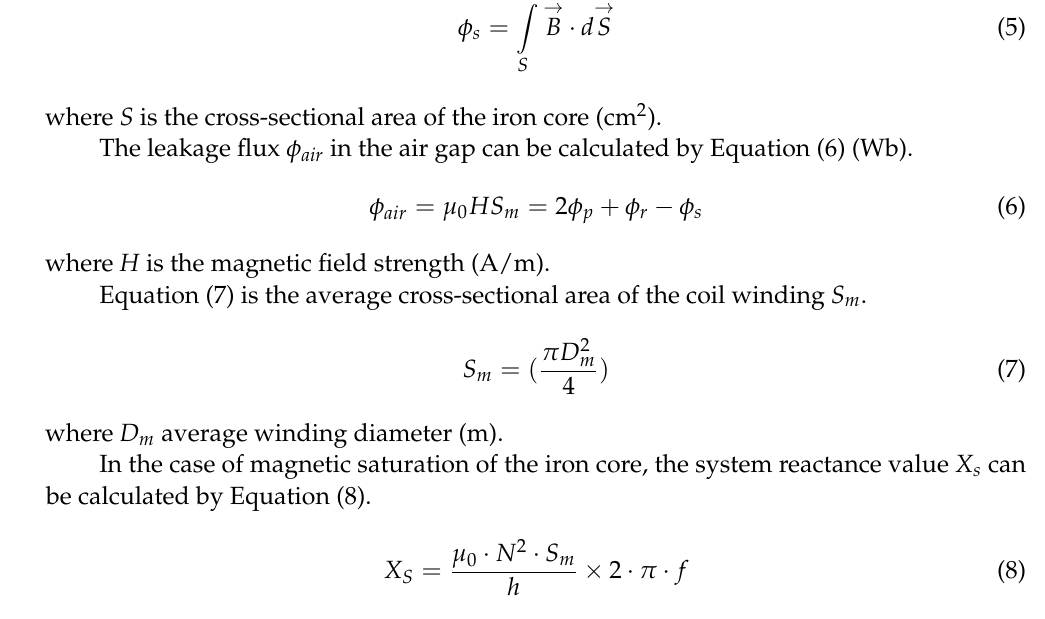
Figure 3. Typical inrush current waveform.